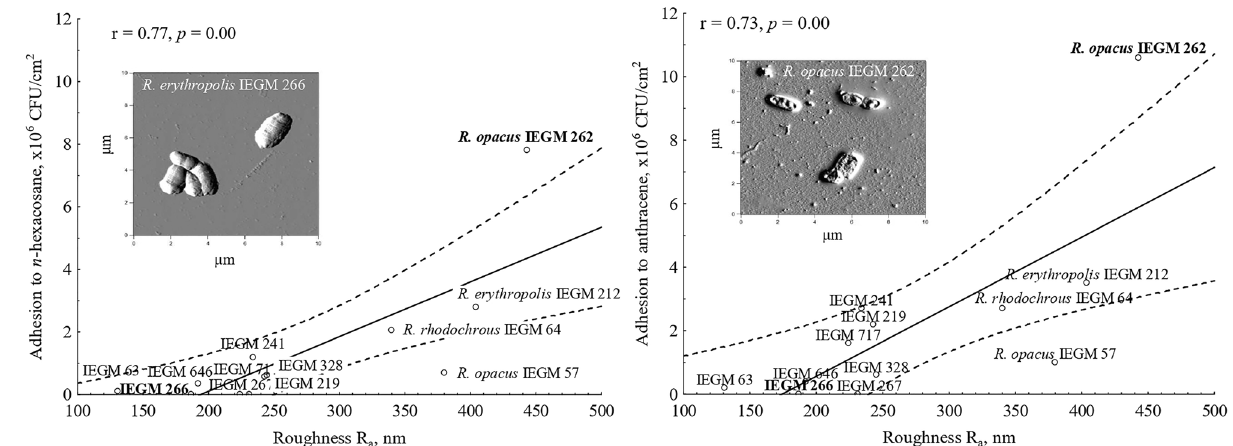
Figure 5. Correlations between surface roughness of Rhodococcus cells and their adhesive activities towards n- hexadecane and anthracene. Means, regression lines and 95% confidence limits are shown in the graphics; r— Pearson’s correlation coefficient, statistically significant at p < 0.05. Cells of strains with high (right) and low (left) levels of roughness are shown in the AFM